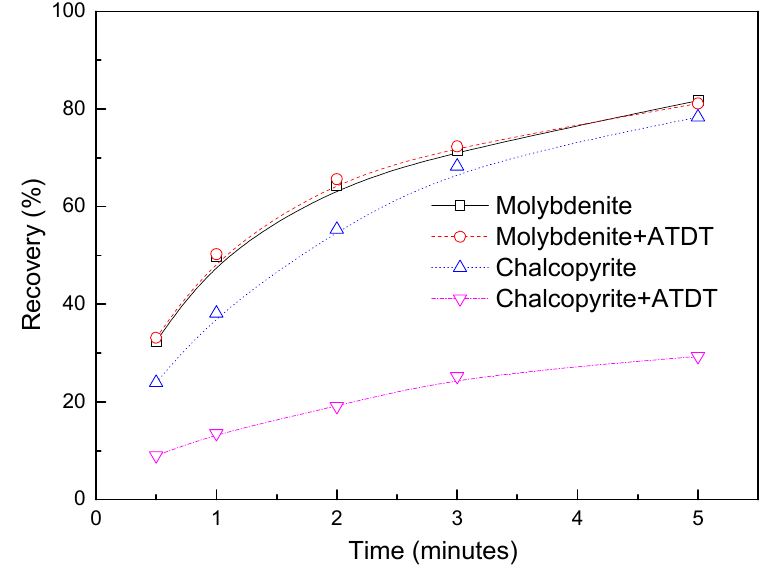
Figure 4 Recovery vs. flotation time with and without ATDT. Figure 4. Recovery vs. flotation time with and without